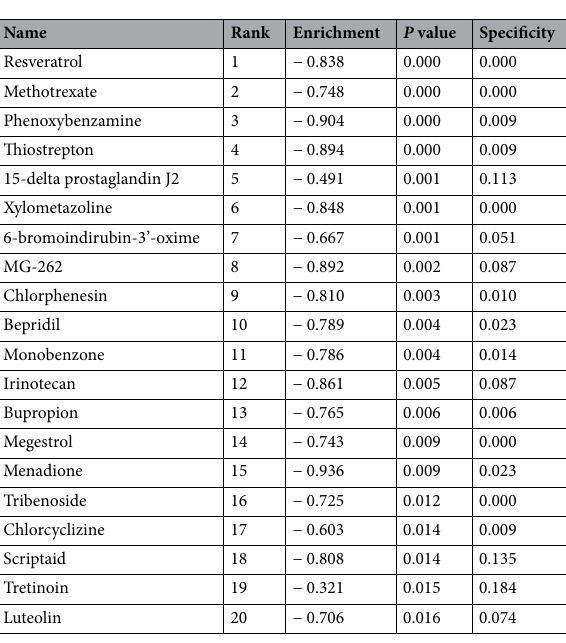
Table 1. CMap database drug screening.